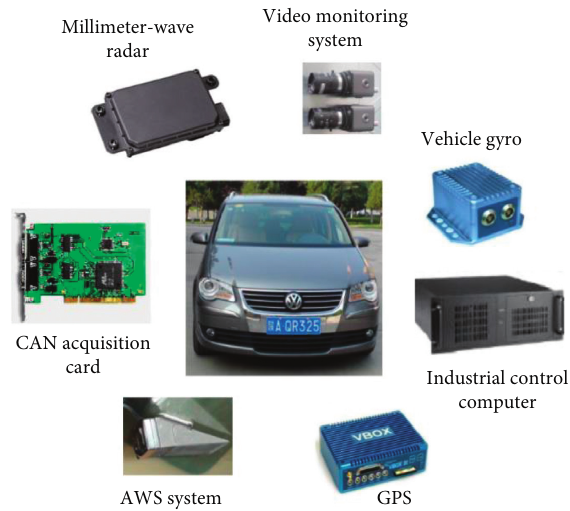
Figure 2: The vehicle and equipment used in the